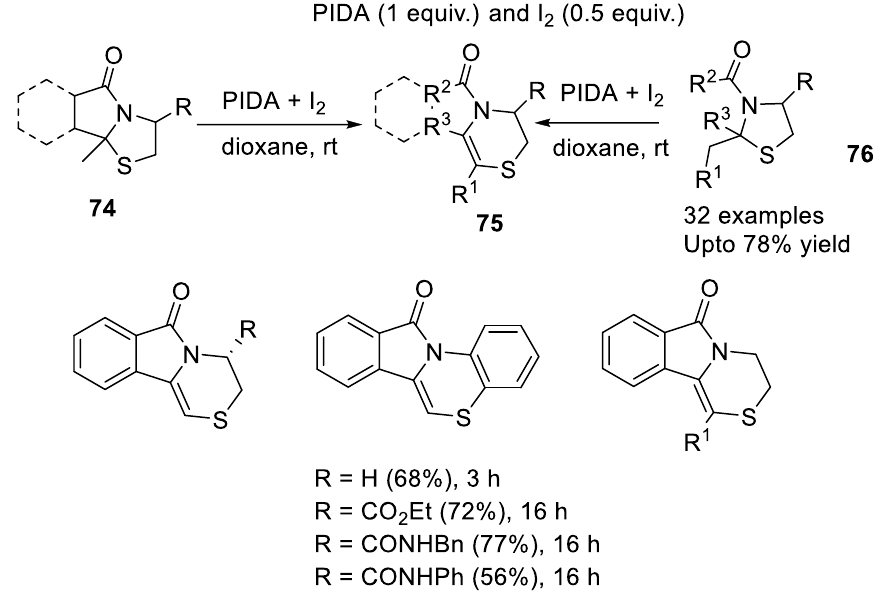
Scheme 13. PIDA-mediated Morin rearrangement.